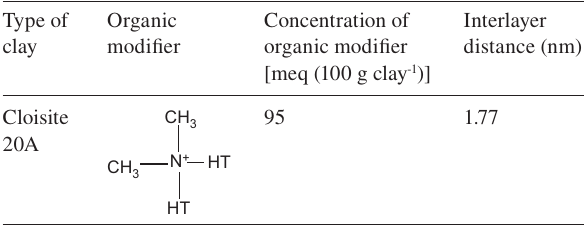
Table 1 Organic modifi er and interlayer distance of the